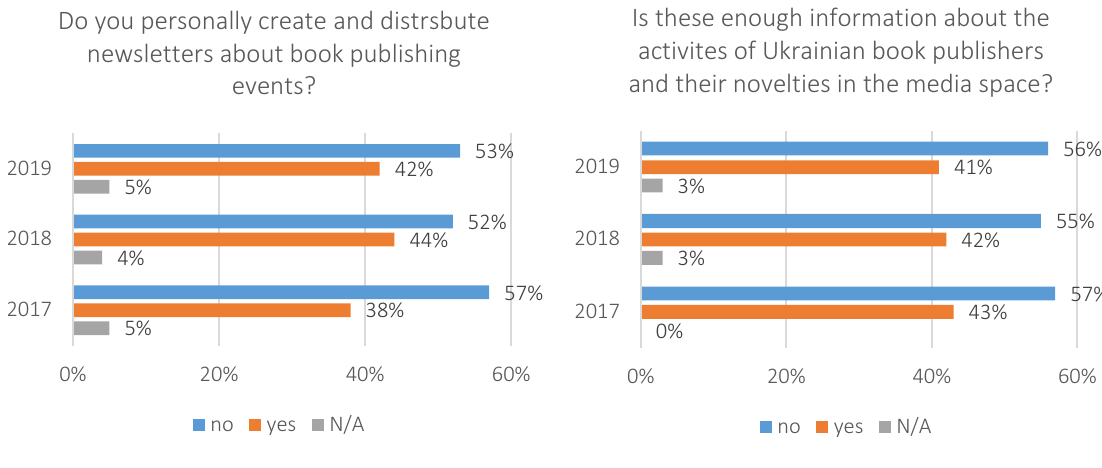
Figure 1. The poll results of the Book Arsenal visitors in Kyiv